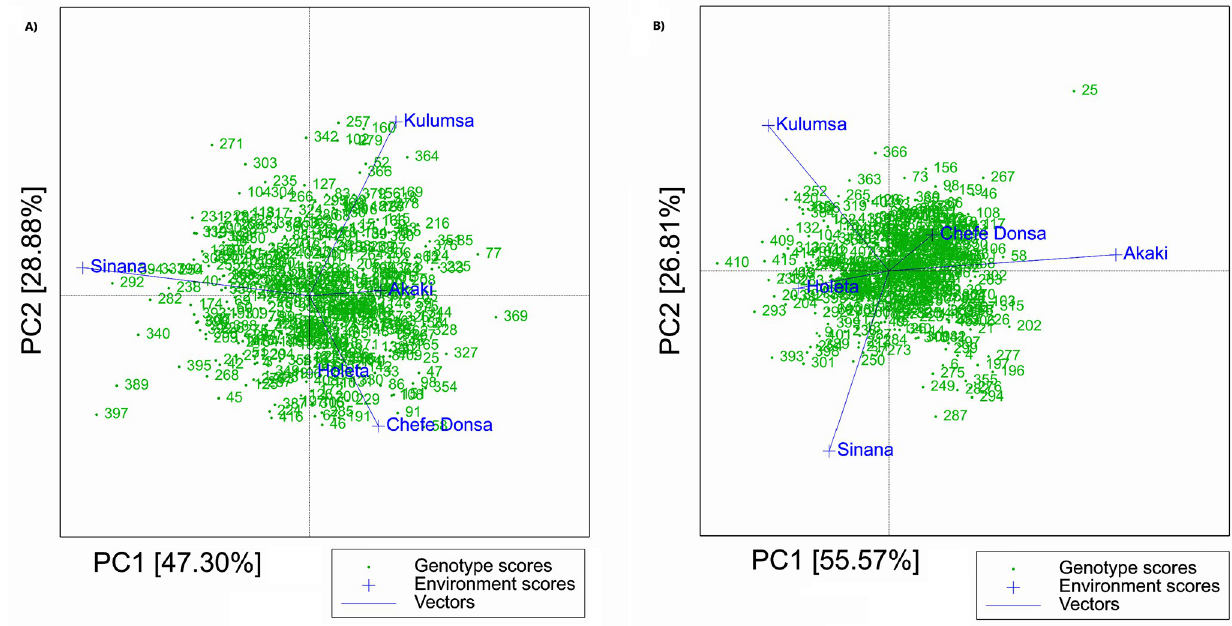
Fig 3. Additive main effect multiplicative model 2 (AMMI2) biplot for grain yield (A) and thousand-kernel weight (B) for 420 durum wheat genotypes and five test sites, respectively.